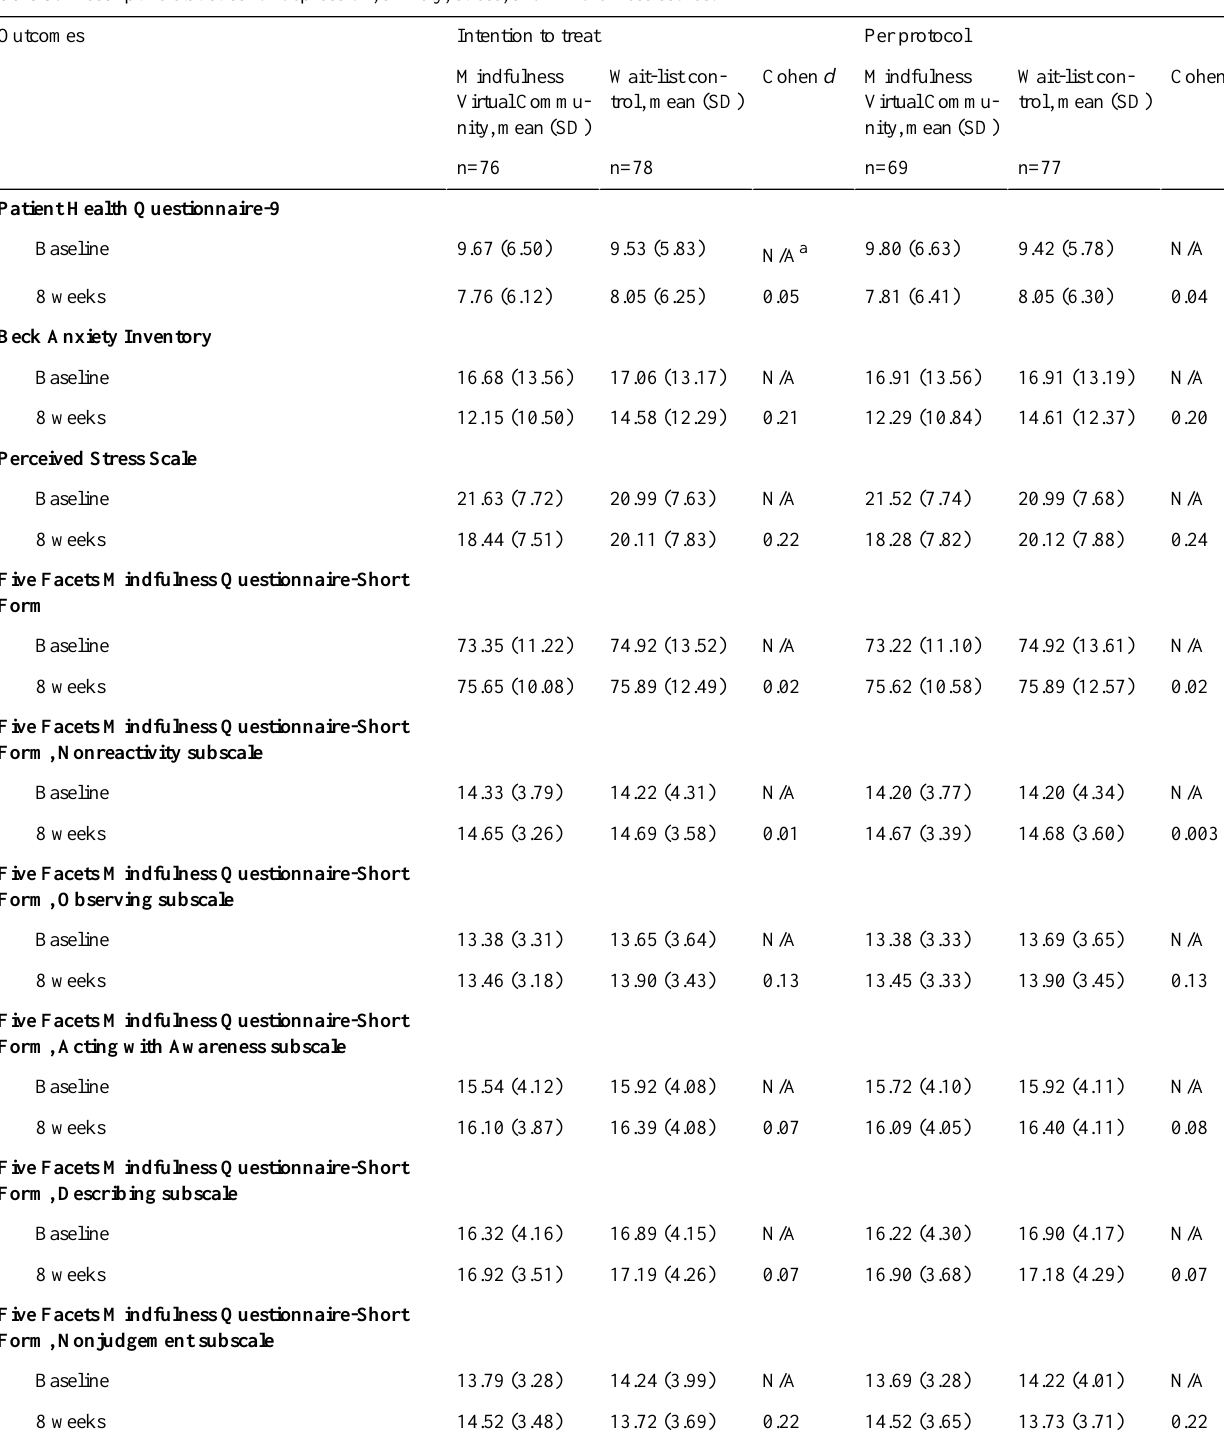
Table 3. Descriptive statistics for depression, anxiety, stress, and mindfulness